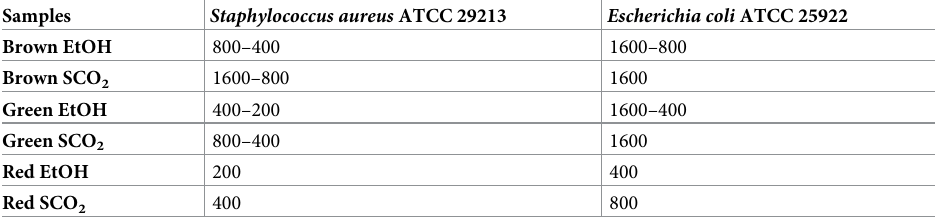
Table 5. Determination of MIC ( μ g.mL -1 ) of the extracts from different samples of propolis obtained by ethanolic extraction (EtOH) and by supercritical extraction (SCO 2